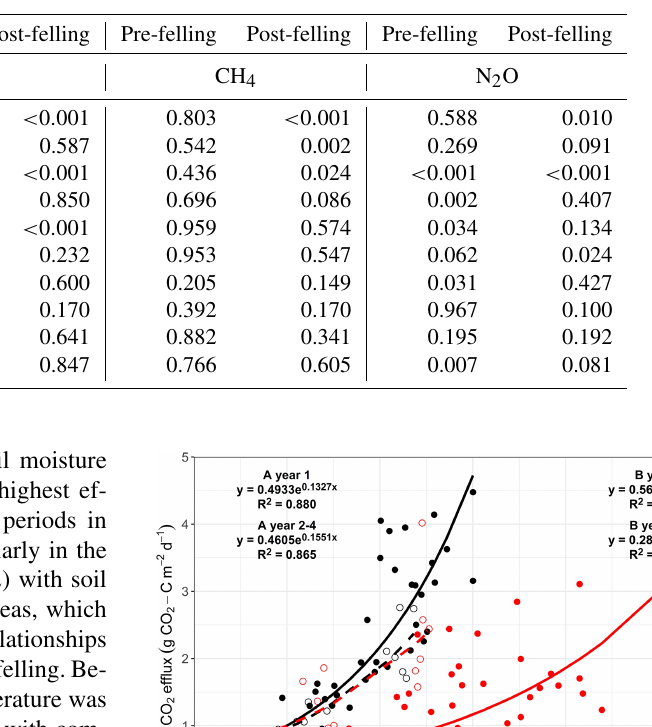
Table 2. Results from the analysis of deviance (chi-square tests) showing the probability ( p ) values for the effects of the explanatory factors and variables: felling, soil temperature (at two depths 2 and 10cm), volumetric soil moisture measurement date, and their interactions (as fixed effects) on soil CO 2 , CH 4 , and N 2 O fluxes in Harwood Forest. Note: p< 0 . 05 is deemed significant; pre-felling denotes the comparison between area A (mature spruce stand remaining) and area B (before clear-felling) in year 1; post-felling denotes comparisons between the areas for year 2 to 4.